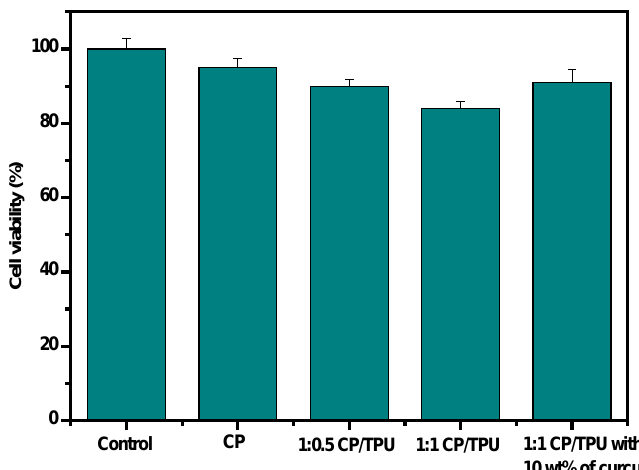
Figure 9. Cell viability of HaCaT cell line for composites.